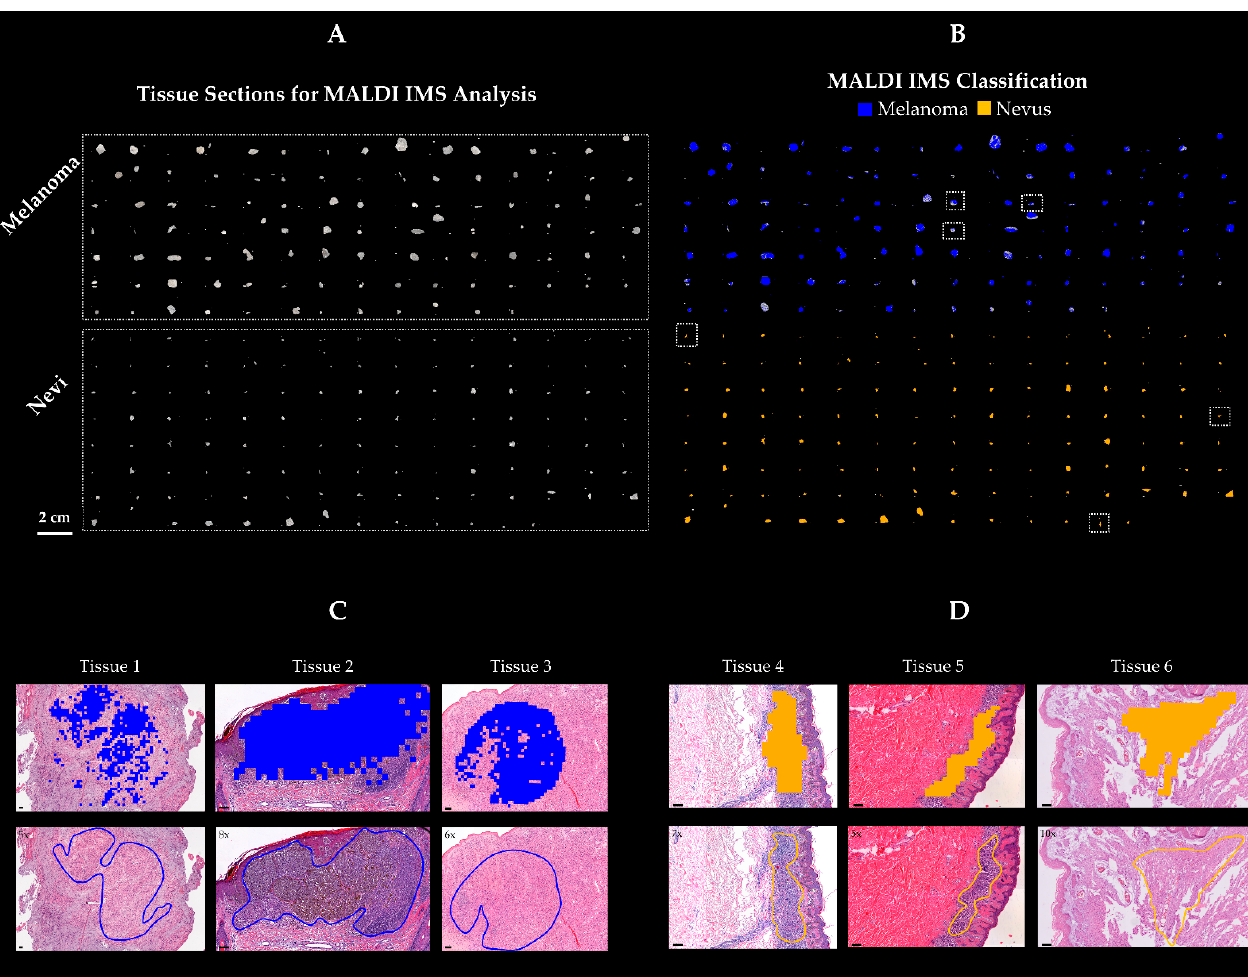
Figure 3. Imaging mass spectrometry classification results. ( A ) Cohort of melanoma ( n samples = 101) and nevi ( n samples = 102) tissues. ( B ) Statistical classification model (LDA) was applied to all tissues and visualized in a color-encoded representation. Specifically, blue was used for melanoma and yellow was used for melanocytic nevi classification. Class images resembled the histopathological diagnosis made by pathologists. Enlargement of the MALDI IMS classification result of some representative tissues ( B , dashed square) is shown for three melanoma ( C , Tissue 1, Tissue 2, Tissue 3) and three nevi ( D , Tissue 4, Tissue 5, Tissue 6). MALDI IMS classification of melanoma ( C , pixels in blue) and melanocytic nevi ( D , pixels in yellow) is in agreement with the histopathological diagnosis ( C , annotated regions in blue line = melanoma; D , annotated region in yellow line = nevi). Scale bar = 100 µm.